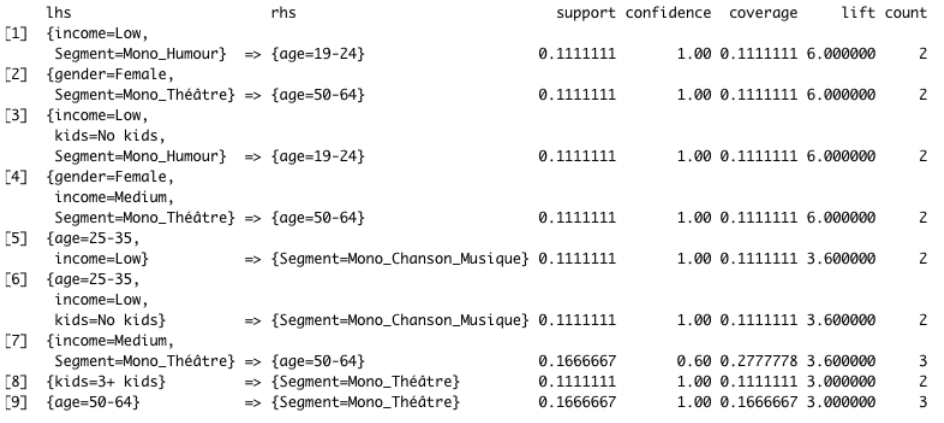
Fig. 5. Customer segmentation as Knowledge-as-a-Service.